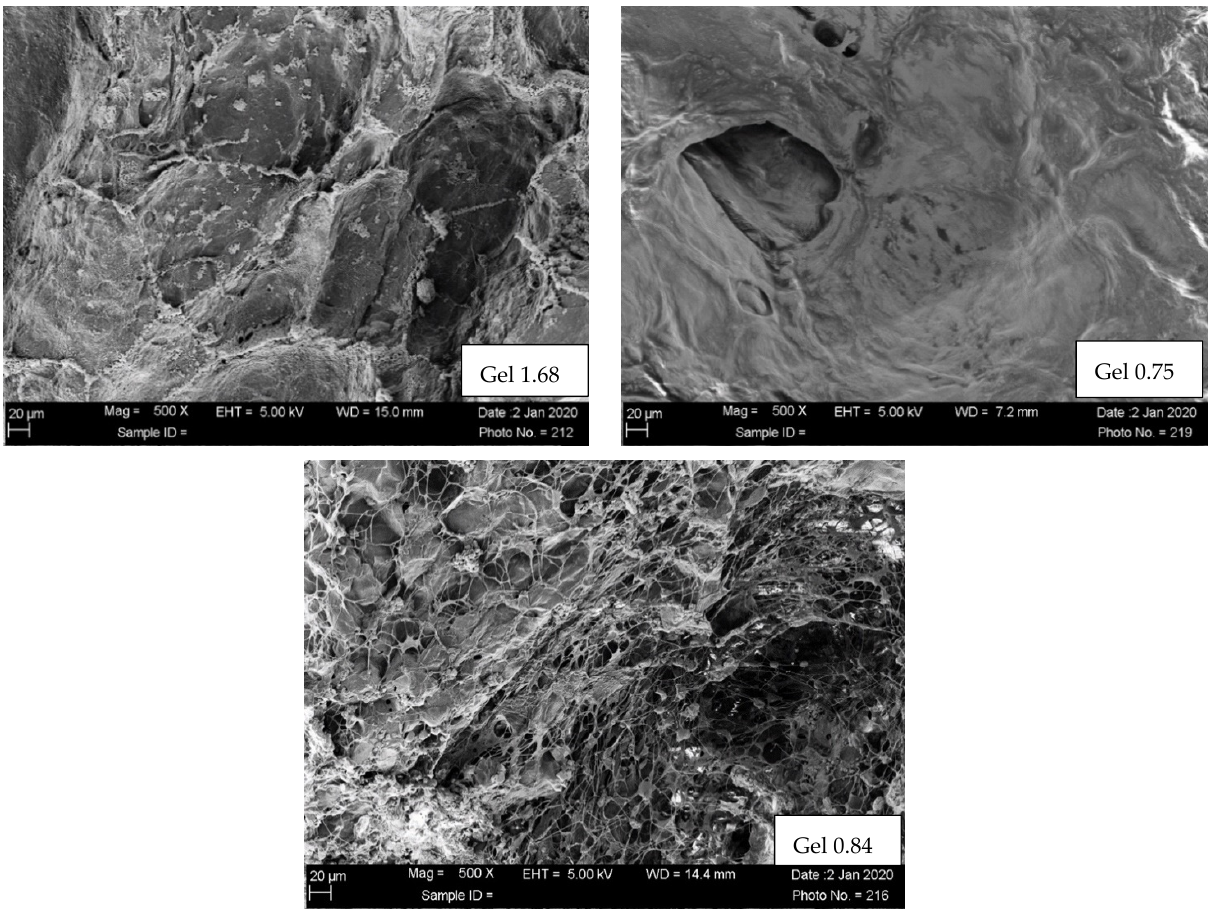
Figure 2. SEM of freeze-dried composites. Scaffold morphologies of ELP hydrogels examined using SUPRA 40 scanning electron microscopy (SEM, Carl Zeiss, Thornwood, NY, USA) at 5 kV. The hydrogels were freeze-dried and sputter-coated with Au/Pd for 1.5 min at 9 V.